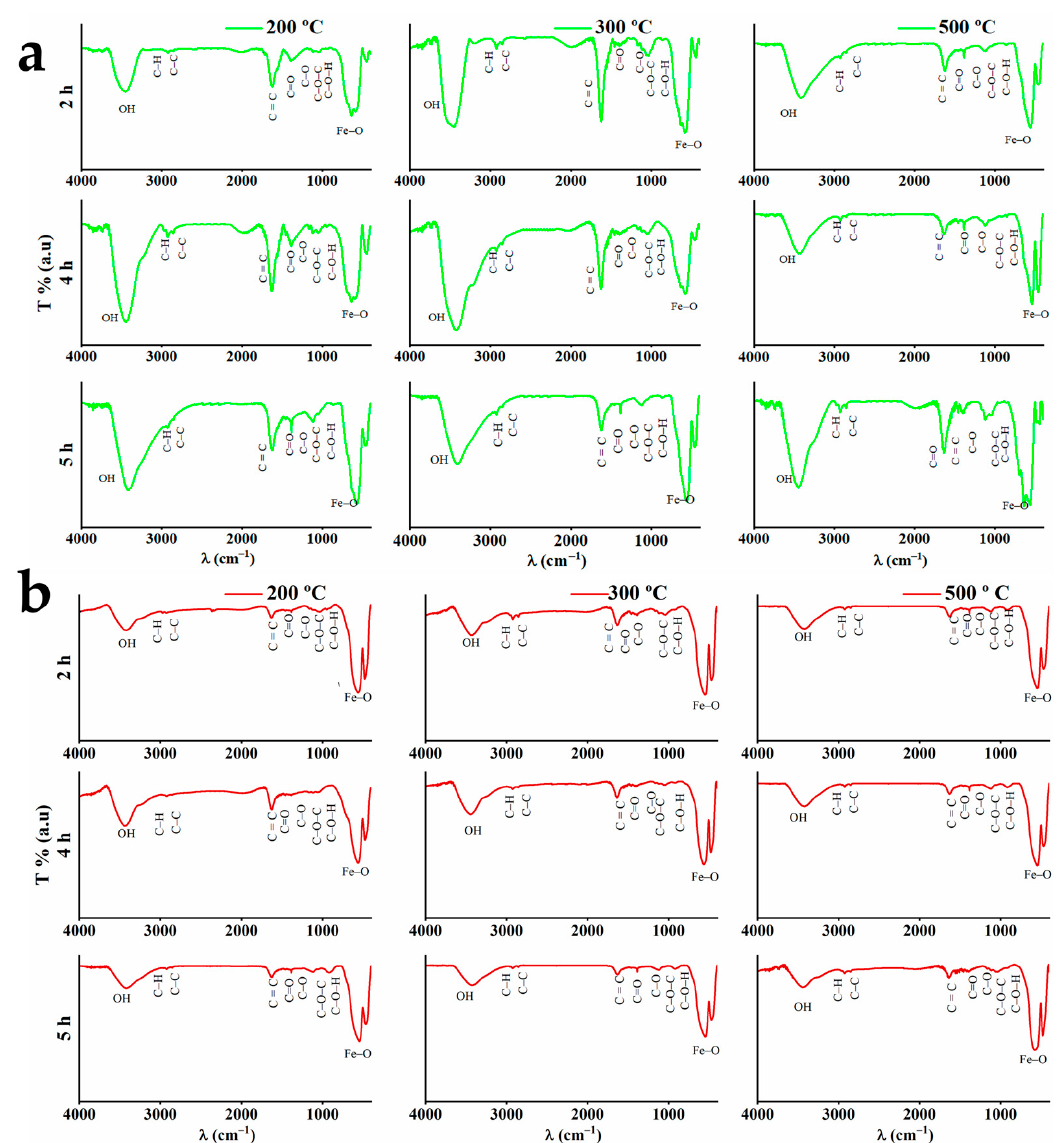
Figure 2. General FTIR spectra (4000–400 cm − 1 ) of the nanoparticles calcined at different temperatures (200, 300, and 500 ◦ C) and times (2, 4, and 5 h): ( a ) GS-NPs profile using aqueous extracts of PDL and ( b ) CS-NPs profile using